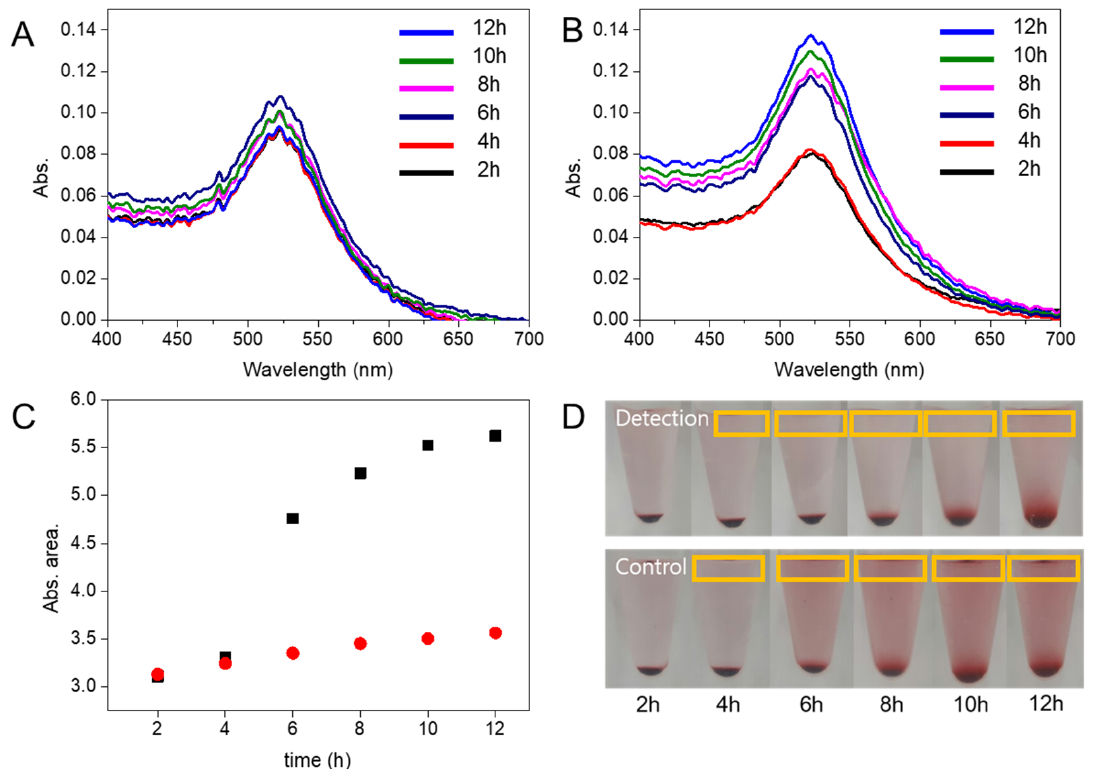
Figure 3. Real-time detection of EGFR exon 19 deletion mutant #2. UV-vis absorbance spectrum ( A ) detection experiment, ( B ) control experiment and relatively. ( C ) area of UV-vis absorbance spectrum (black square: control experiment; red dot: detection experiment), and ( D ) centrifuge cell picture, according to re-dispersion time. The concentration of EGFR mutant DNA was 3.85 × 10 − 1 M.